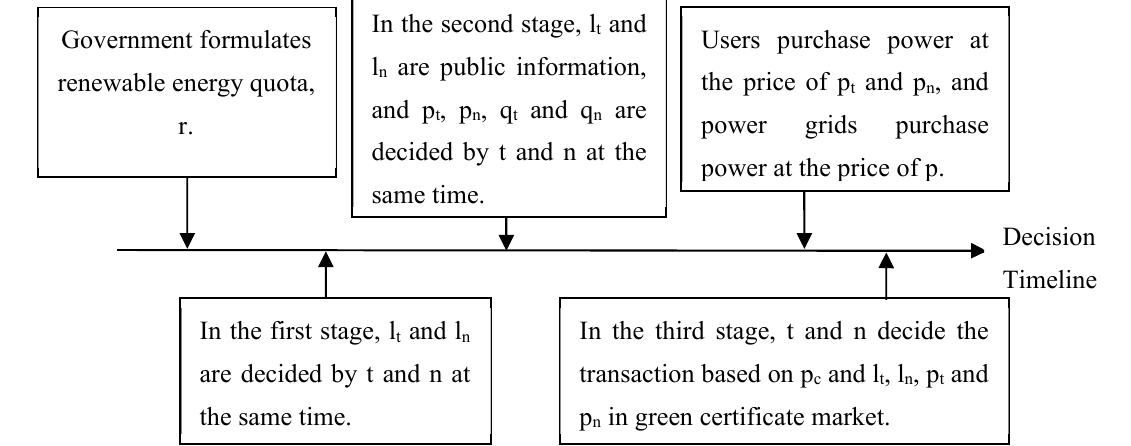
Figure 2. Timeline of renewable energy investment and production decisions.